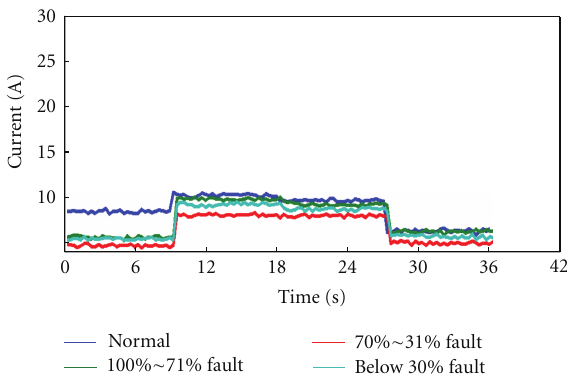
Figure 16: Each fault current curve in the first module.